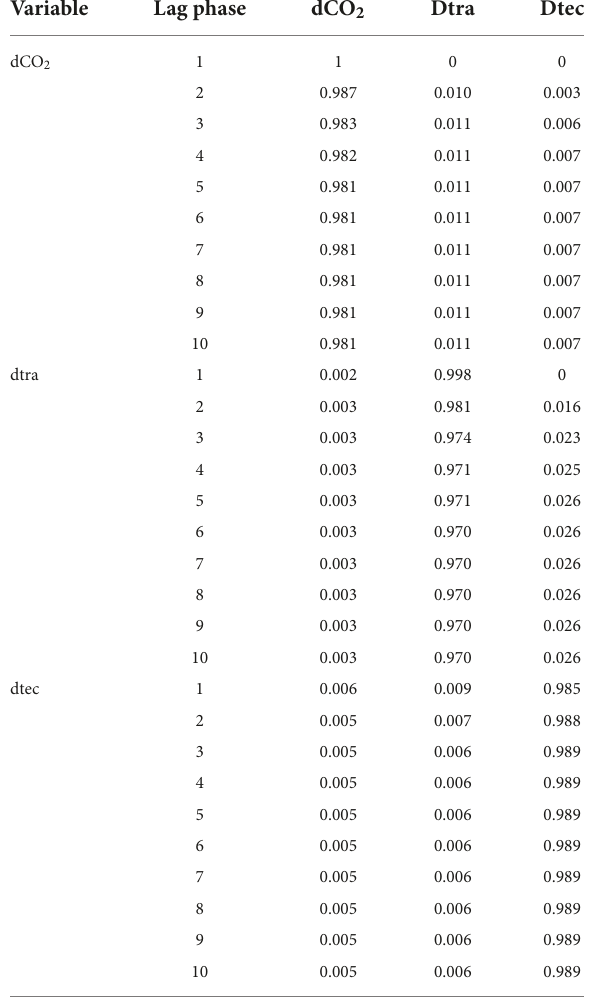
TABLE 6 Variable variance decomposition